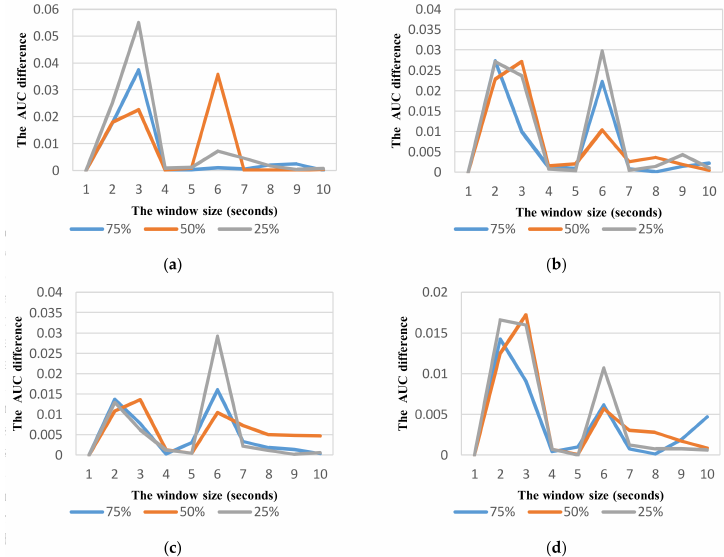
Figure 15. The performance result (AUC) of detecting the activity Turning right with respect to window size and overlapping ratio.